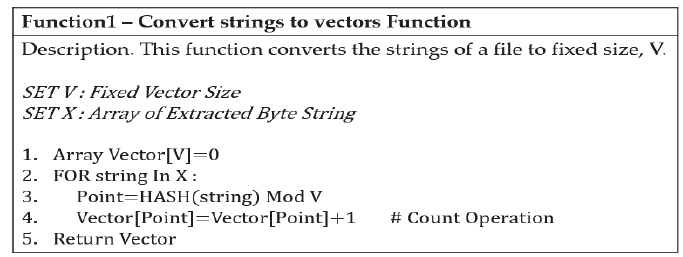
Figure 9. Strings vectorization pseudo-code.